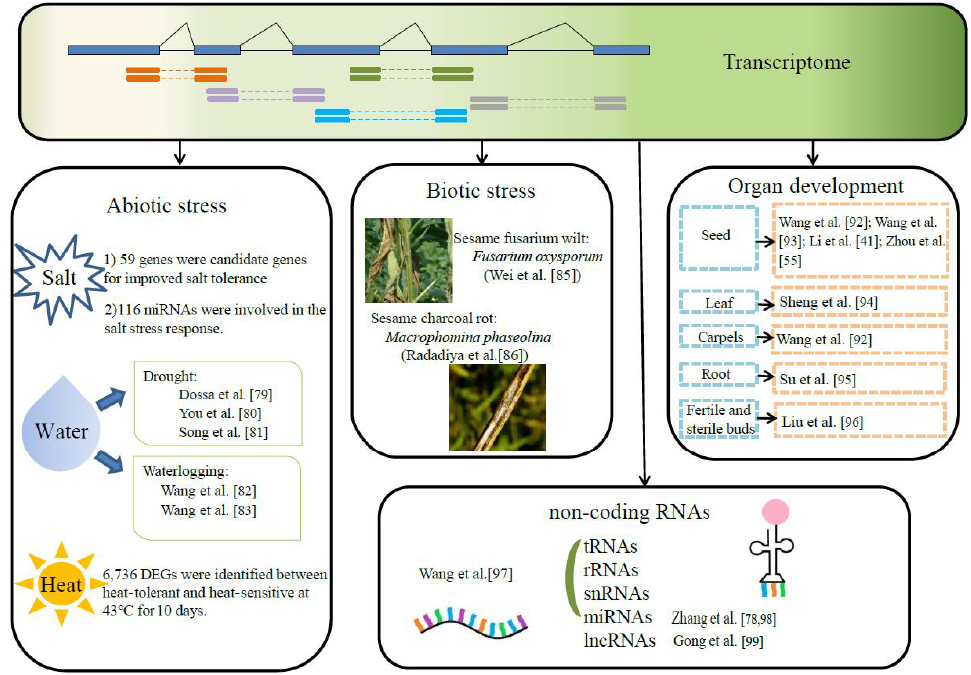
Figure 4. The applications of transcriptomics approaches in sesame. The research of sesame under abiotic stress is introduced from the aspects of salt, water and heat temperature [76–83]. The biotic stress illustrates two main sesame diseases: sesame fusarium wilt and charcoal rot [84,85]. In terms of organ development, seeds, leaves, carpels, roots, fertile and sterile buds are introduced [41,55,86–90]. It also introduces several non-coding RNAs, such as tRNAs, rRNAs, miRNAs, lncRNAs